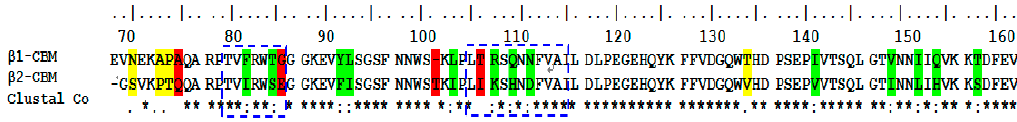
Figure 2. Sequence alignment of carbohydrate-binding module from the β 1 and β 2 subunits. Asterisks indicate positions that have a single, fully conserved residue. Colon (green) indicates conservation between groups of strongly similar properties. Period (yellow) indicates conservation between groups of weakly similar properties. Blank character (red) indicates conservation between groups of strongly different properties.